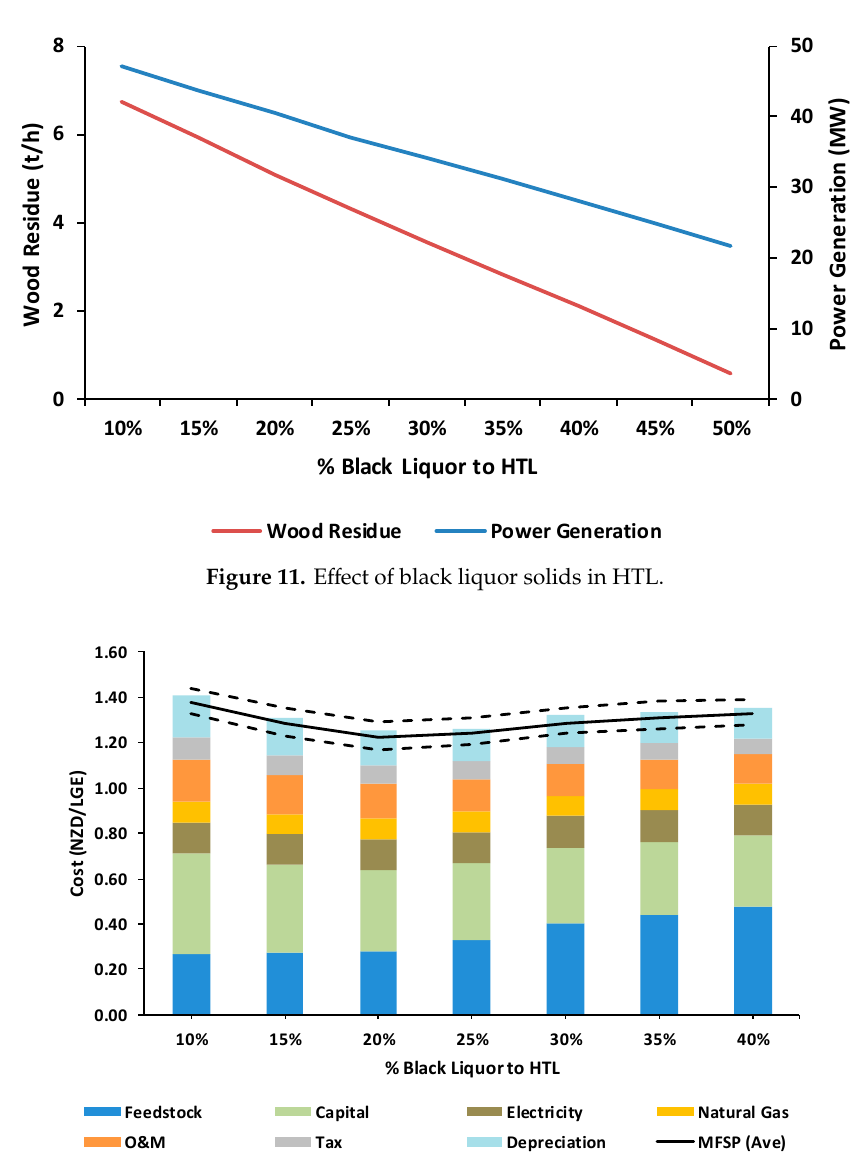
Figure 12. MFSP and the breakdown of the levelised production costs of the kraft mill-integrated HTL with a new recovery boiler, with different processing size.